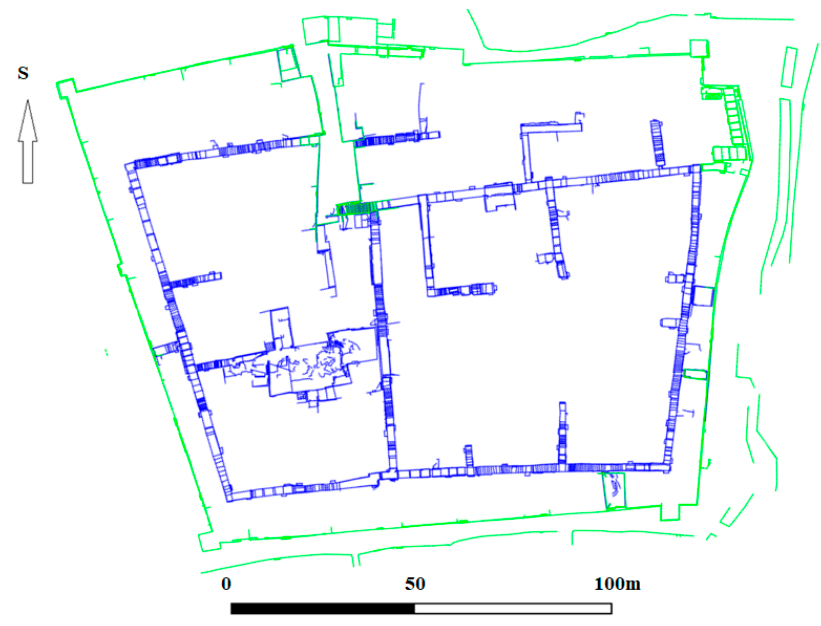
Figure 26. After transformation of both models from vectorized scans, an appropriate ground plan was made.